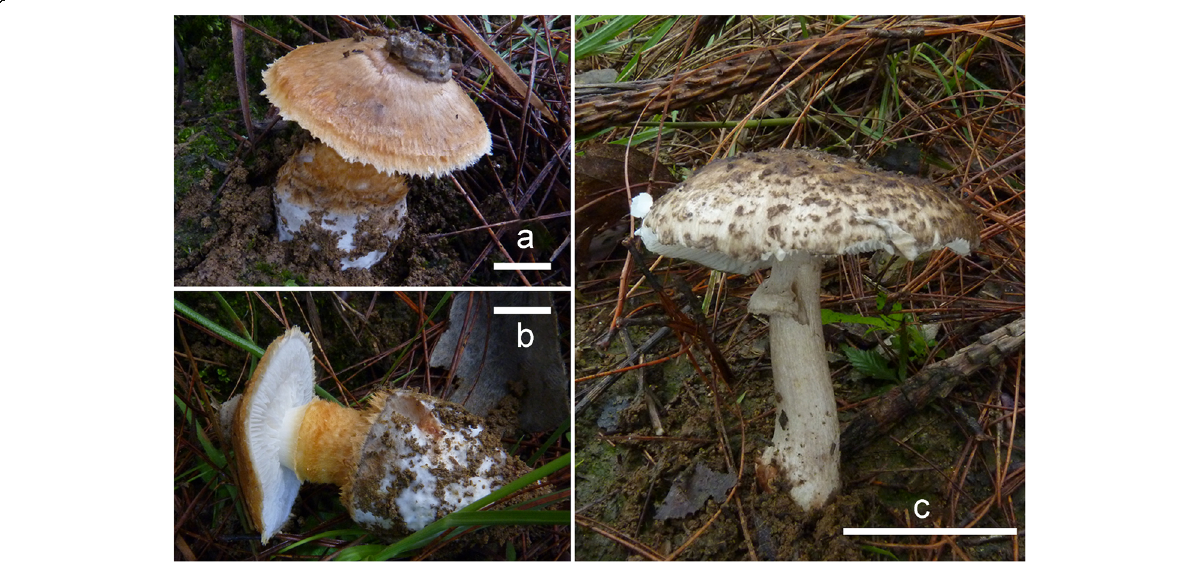
Fig. 8 a – b Basidiomes of Squamanita orientalis (HKAS74862A, holotype). Photos by Gang Wu. Bars: 10 mm. A lump of clay is attached on the center of pileus, and the apical part of volval remnants on mycocecidiium can be observed between clay and pileus under anatomical lens. c Basidiome of Amanita sepiacea (HKAS74861). Photos by Gang Wu. Bars: 50